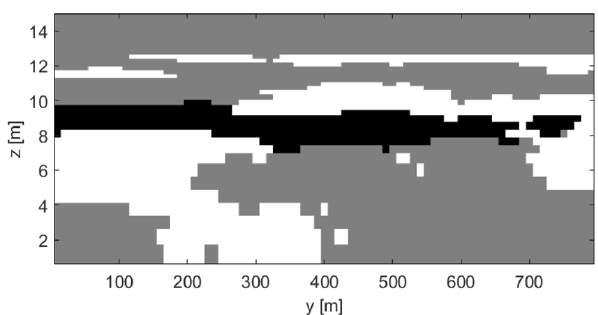
Figure 8. Distribution of soil types along the 800m side at x = 195m in the 3D flow model. gray: loam, white: loamy sand, black: sandy